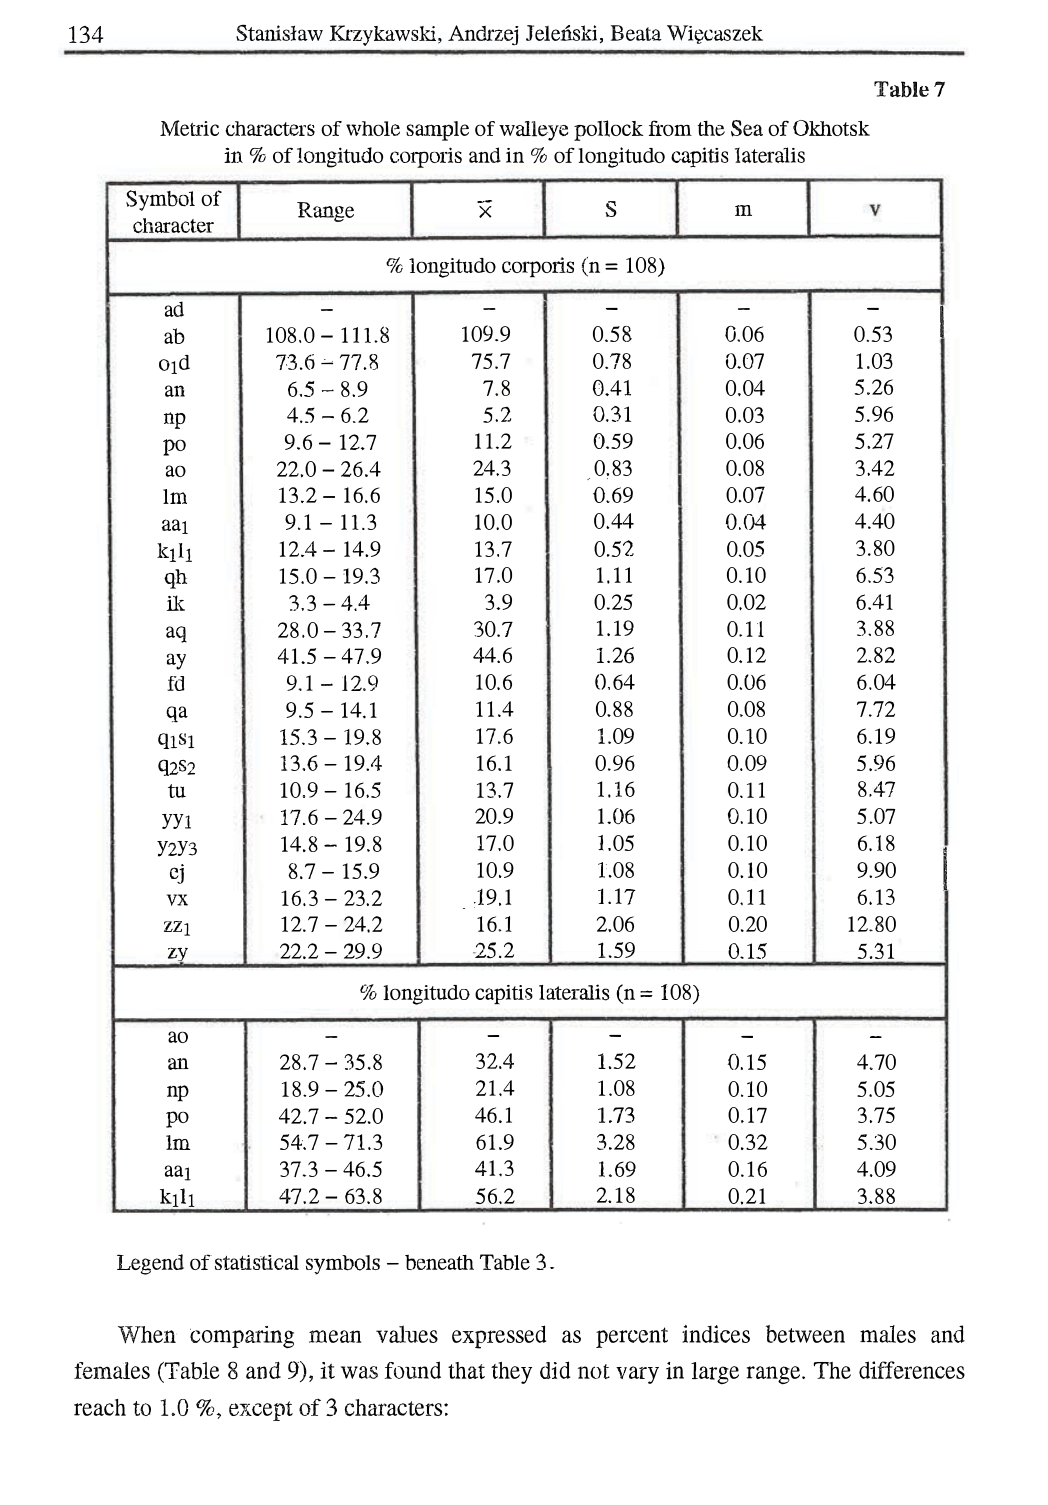
Metric characters of whole sample of walleye pollock from the Sea of Okhotsk in % of longitudo corpmis and in % of longitudo capitis 1ateralis Symbol of